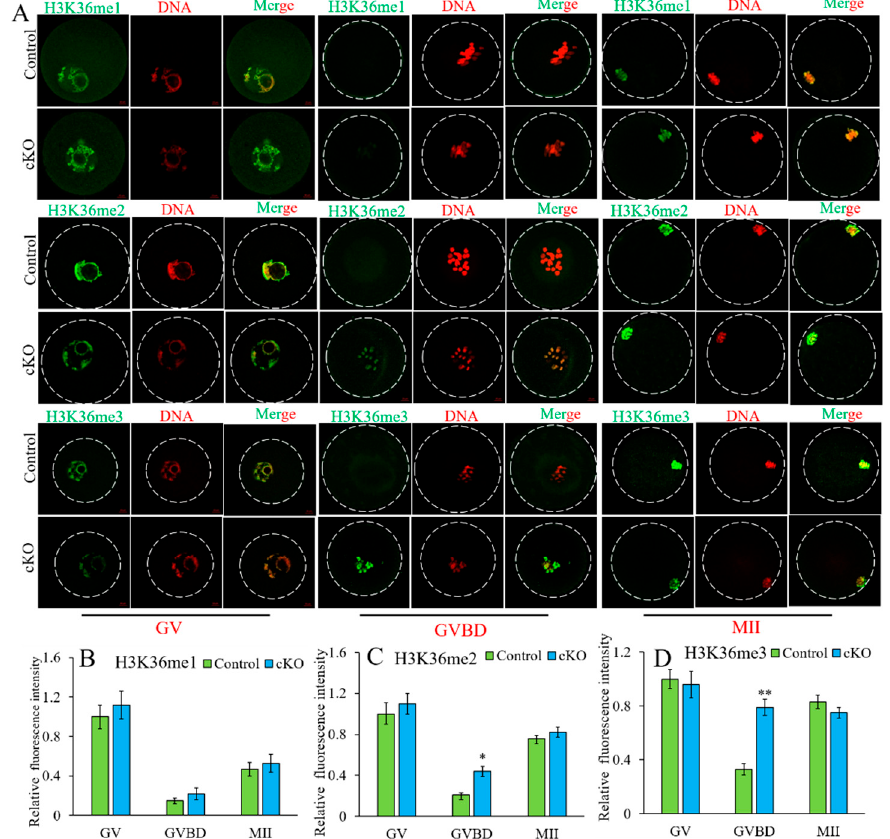
Figure 7. Analysis of H3K36me1/2/3 levels in the GV-, GVBD-, and MII-stage oocytes of control and Kdm2a cKO mice. ( A ) Analysis of H3K36me1/2/3 levels by IF. Oocytes were labeled with anti-H3K36me1/2/3 followed by appropriate Alexa Fluor-conjugated secondary antibodies (green) and were counterstained with the nuclear stain PI (red). ( B – D ) The H3K36me1/2/3 fluorescence intensity in oocytes of control and Kdm2a cKO mice by image pro-plus 6.0. * Significant difference ( p < 0.05) and ** Extremely significant difference ( p < 0.01) from the Kdm2a cKO group compared with the control group.